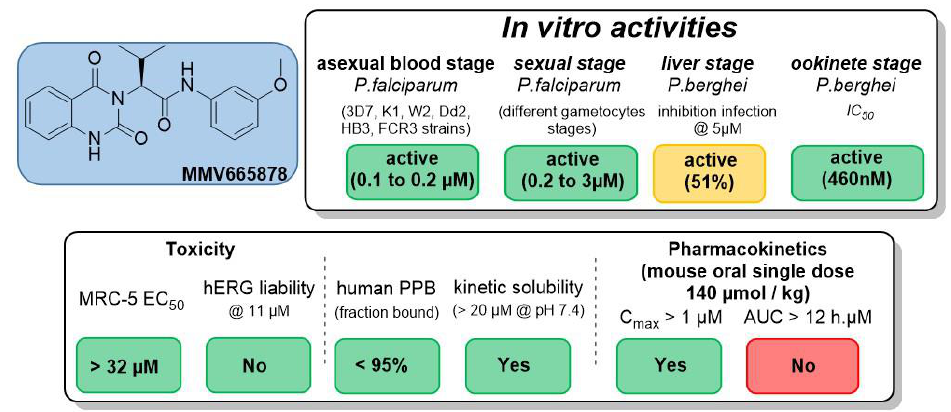
Figure 35. Pharmacological profile of MMV665878.